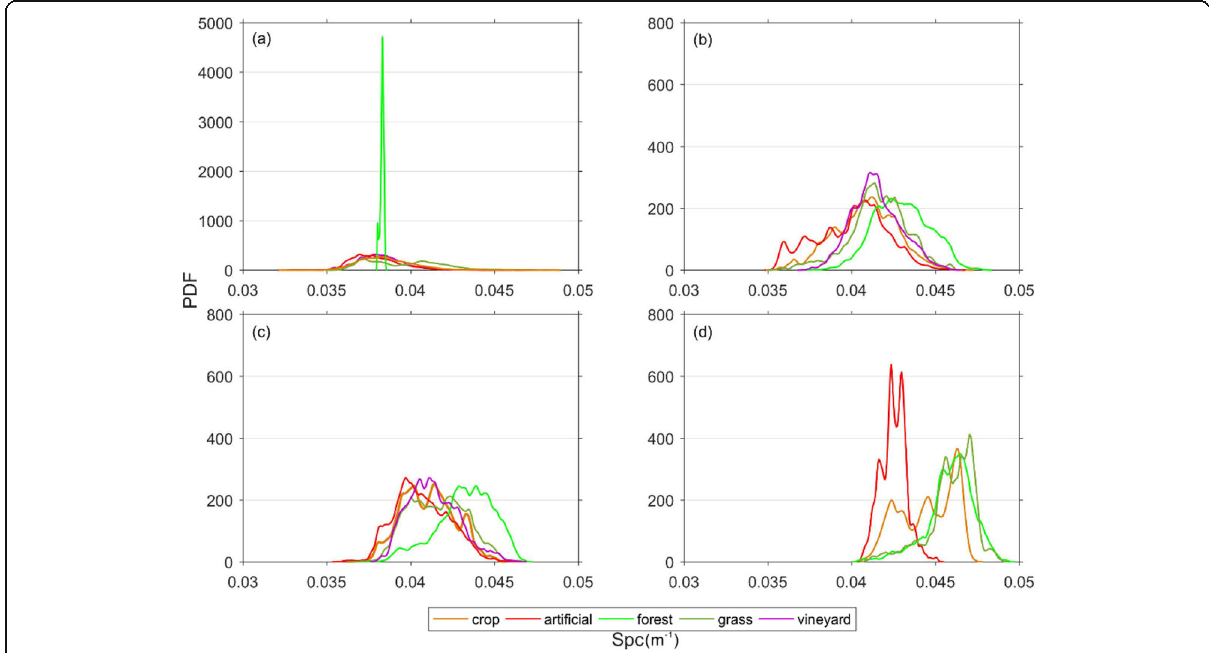
Fig. 13 The PDFs of the Spc . with different land covers in the four areas. a floodplain, b plain to hilly, c hilly, d mountain